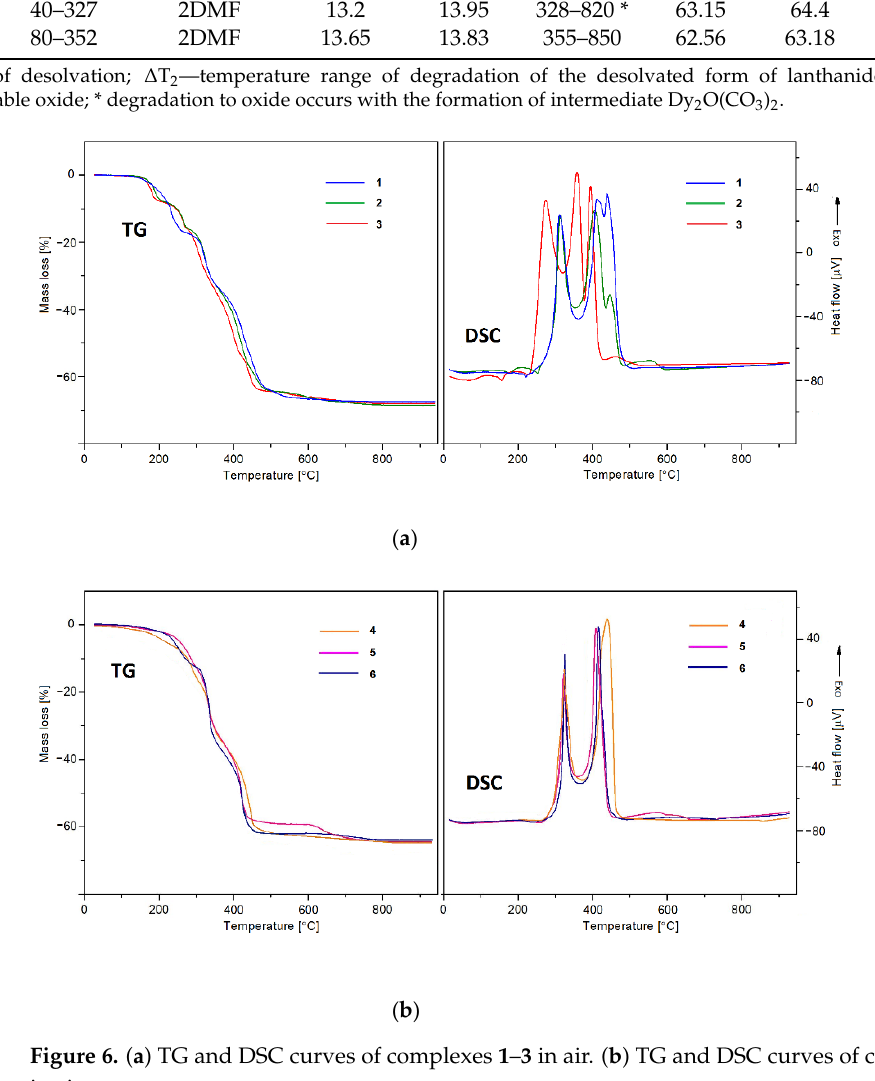
Figure 6. ( a ) TG and DSC curves of complexes 1 – 3 in air. ( b ) TG and DSC curves of complexes 4 – 6 in air. in